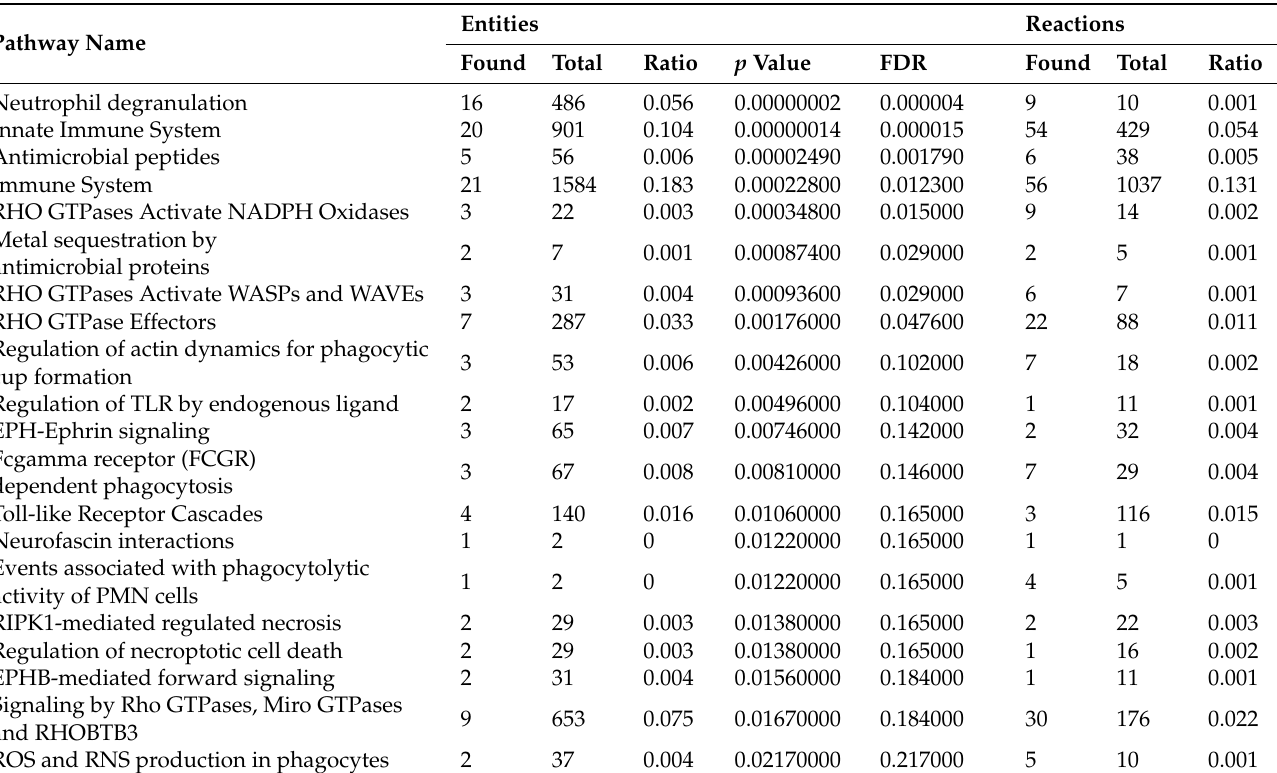
Table 3. Reactome pathways analysis of DE proteins in milk-derive EVs between the CM and Healthy